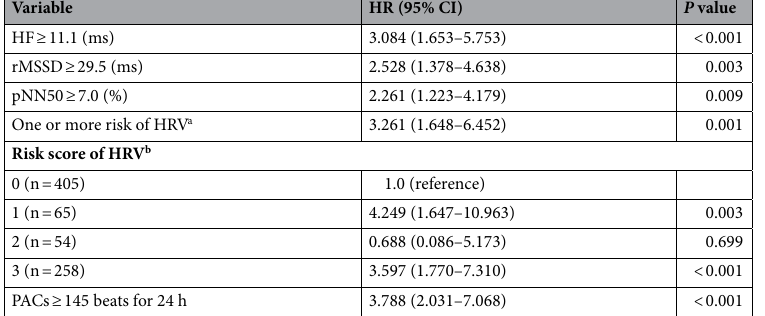
Table 5. Relationship between HRV risk score according to cut–off value and occurrence of atrial fibrillation. HRV, heart rate variability; HF, high frequency; rMSSD, square root of the mean squared differences of successive NN interval; pNN50, the percentage of RR intervals that are more than 50 ms different from the previous interval; PAC, premature atrial contraction. a Indicates that at least one of the above mentioned abnormal HRV parameters (HF, rMSSD, and pNN50) were present. b Sum of the above mentioned abnormal HRV parameter (HF, rMSSD, and